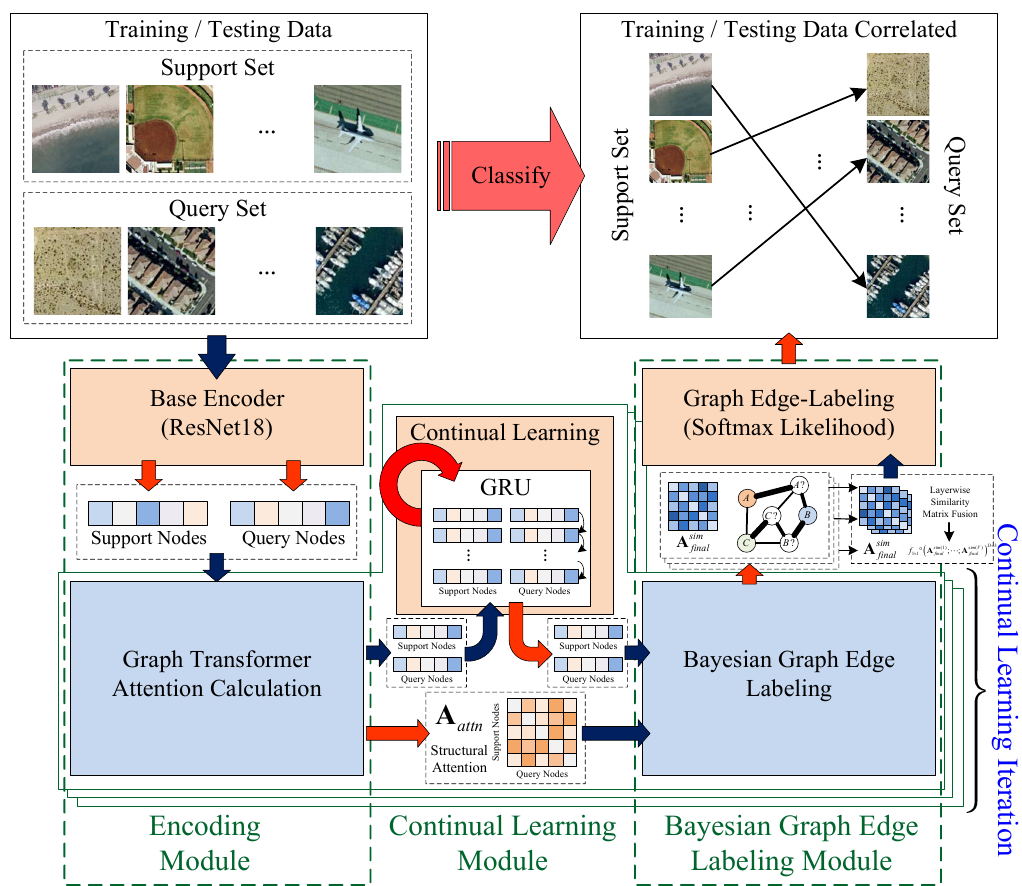
Figure 2. Overview : The proposed continual meta-learning few-shot scene classification algorithm is composed of three main components: The encoding module, the GRU-based continual meta-learning module, and the Bayesian graph neural network-based graph edge labeling module.